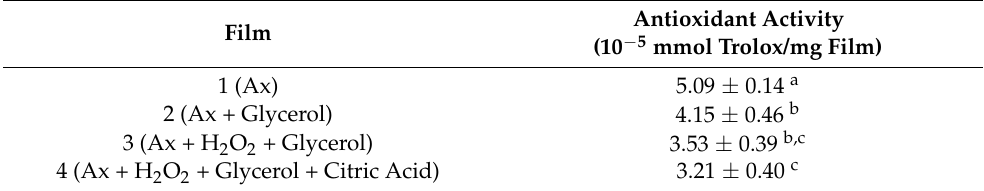
Table 3. Antioxidant activity of films obtained expressed as Trolox equivalents (mmol Trolox/mg film). Values in the same column followed by different superscript letters differ significantly ( p < 0.05).